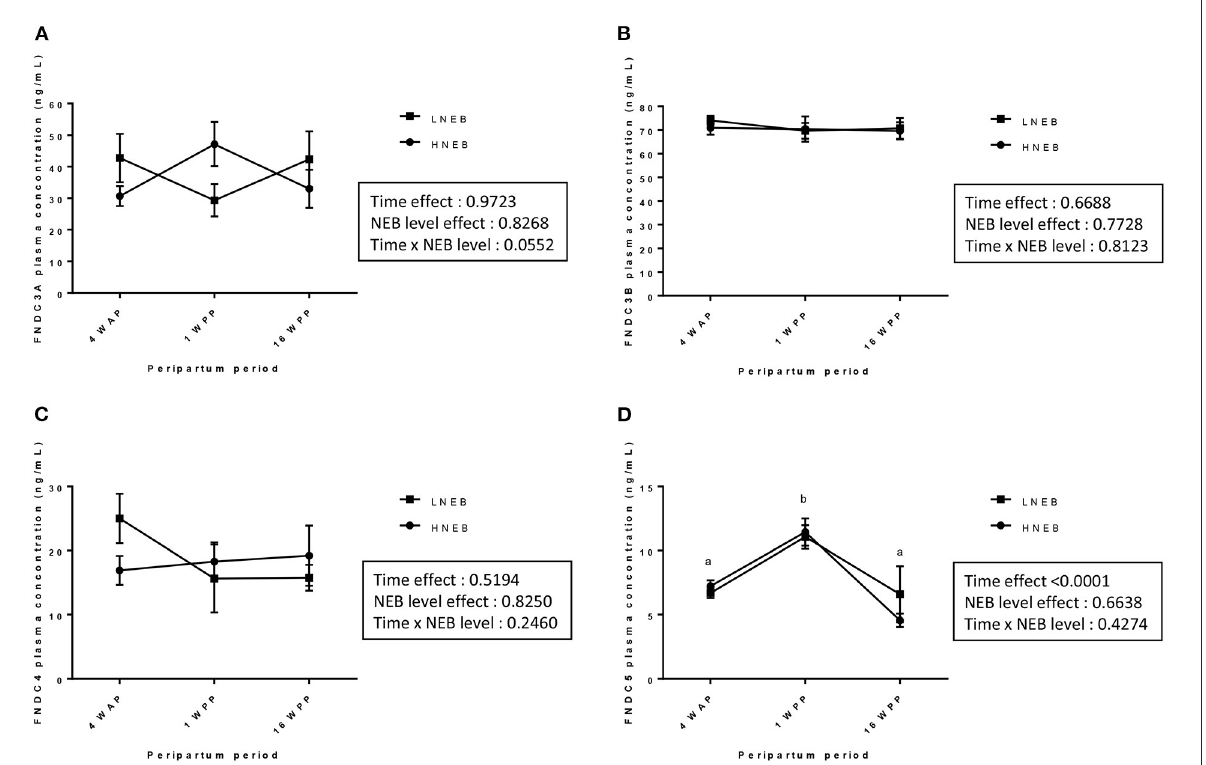
FIGURE2 Plasma concentrations of FNDC proteins at 4 WAP, 1 WPP and 16 WPP in HNEB and LNEB animals. The concentrations of FNDC3A (A) , FNDC3B (B) , FNDC4 (C) and FNDC5 (D) in plasma were determined by ELISA assays. Data are expressed as mean ± SEM for each group of animals (HNEB and LNEB) at each stage of the peripartum period (4WAP, 1 and 16 WPP, n = 8) and analysed by a nonparametric analysis of variance with repeated measures (Friedman test). Groups with different letters were significantly different ( p -value <